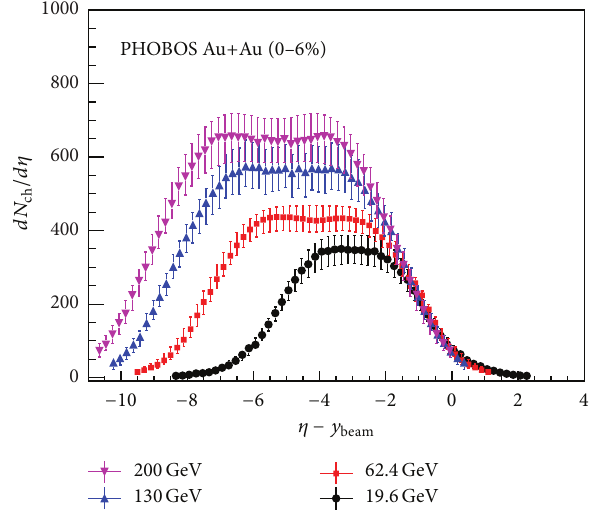
Figure 5: Charged particle multiplicity density normalized by participant pairs for Cu+Cu collisions at different energies, shown in the projectile rest frame by using 𝜂 󸀠 = 𝜂 − 𝑦